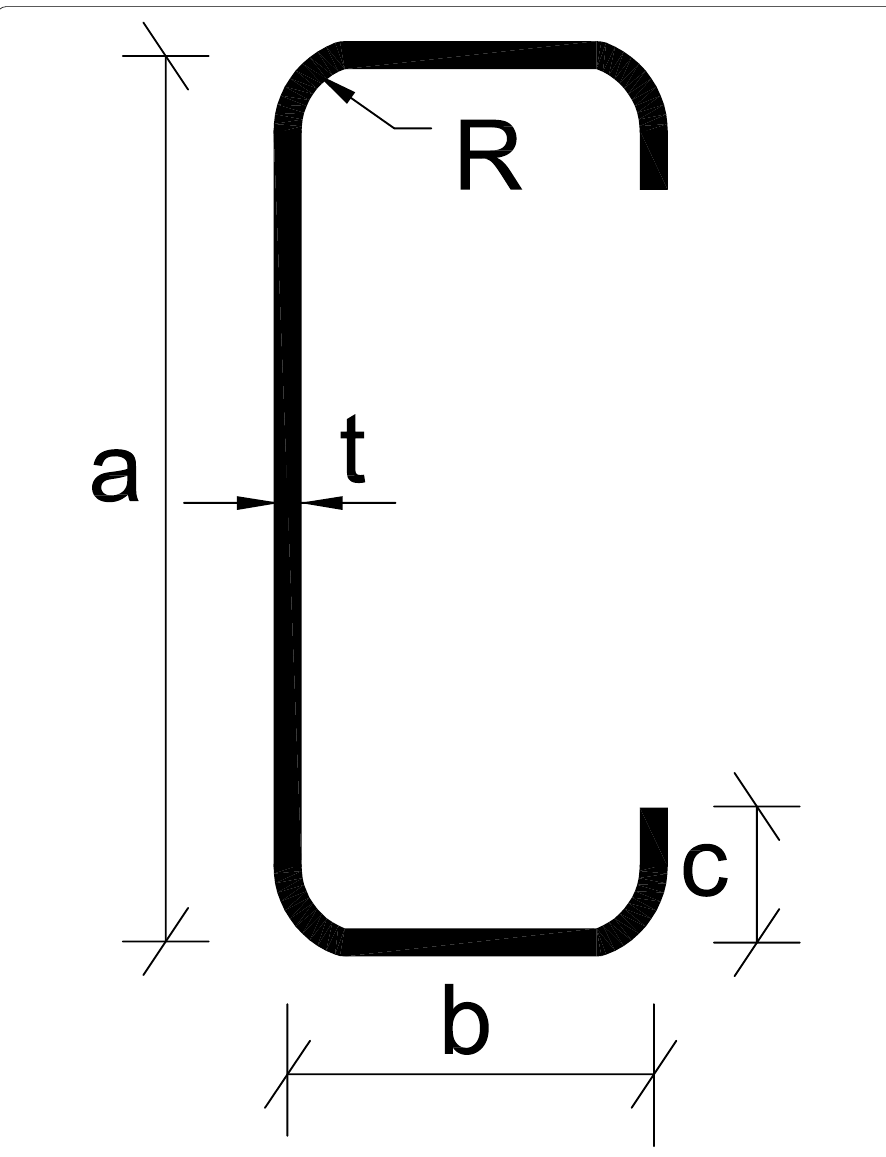
Fig. 1 Dimensions of the cross section of C-lipped